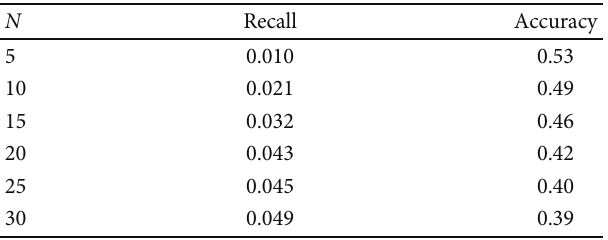
Table 2: Common character recommendation accuracy and recall.